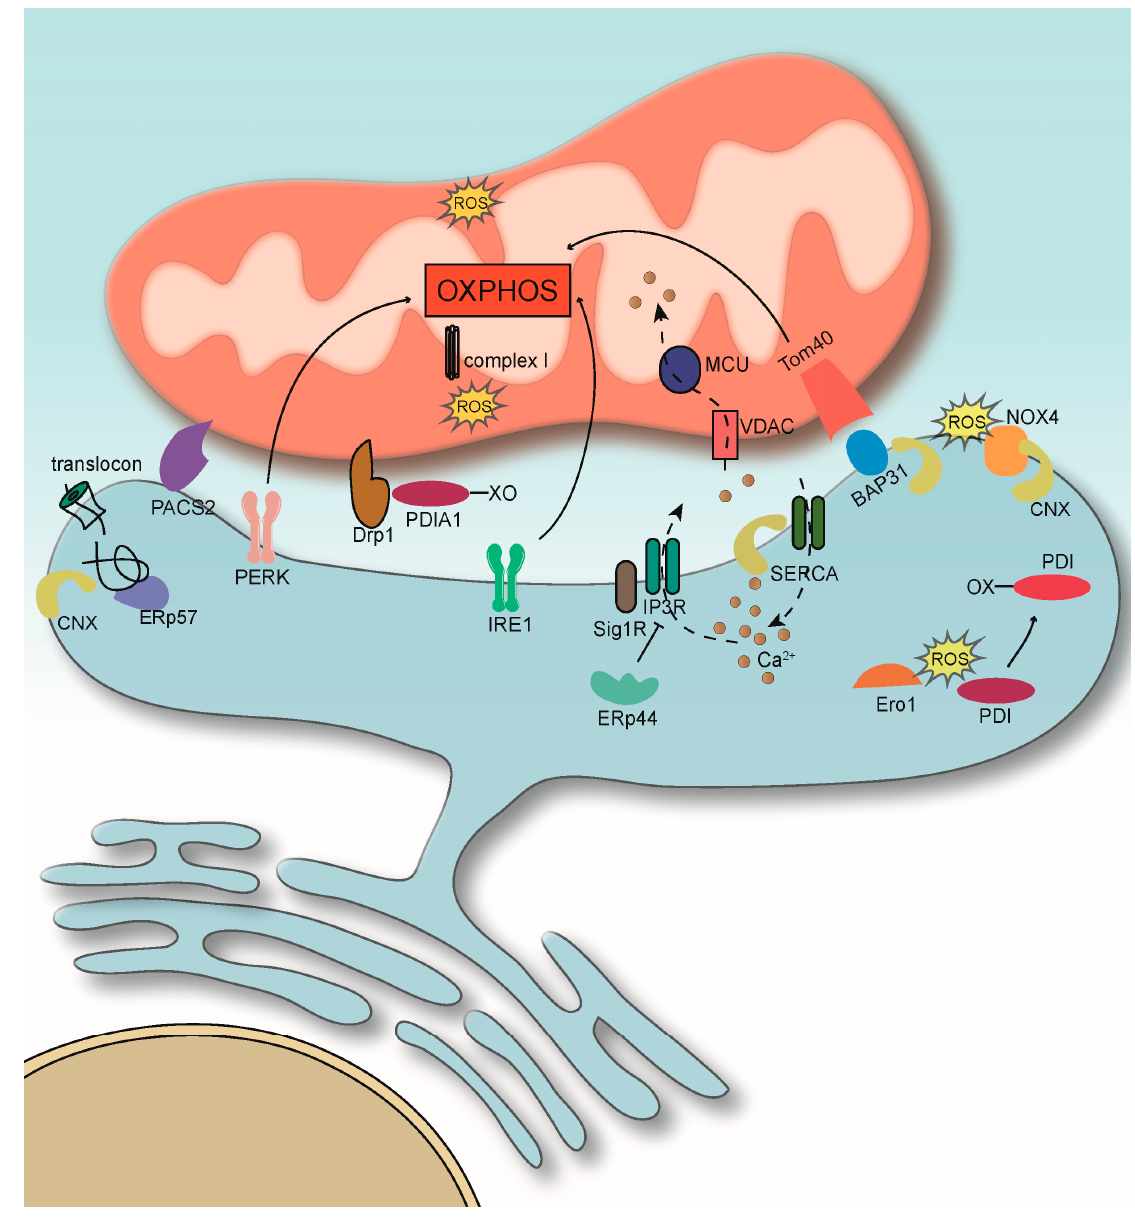
Figure 1. Endoplasmic reticulum (ER)–mitochondria interactions under homeostatic conditions. Unfolded protein response (UPR)-unrelated activities of Ire1 and PERK control mitochondrial metabolism. Ca 2+ homeostatic flux from the ER to mitochondria maintains the Krebs cycle. ER chaperones keep this flux within normal settings. For details, see text.